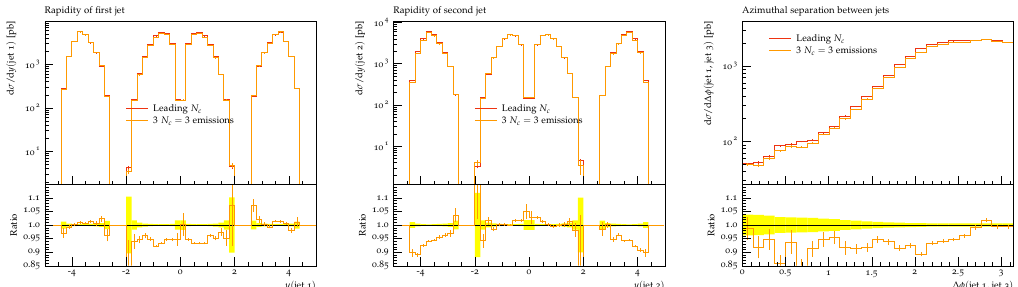
Figure 7 . Rapidity distribution of the hardest jet (left), second hardest jet (middle) and separation in (cid:30) of the hardest and third hardest jets (right). Our standard analysis cut of p ? > 50 GeV is used.